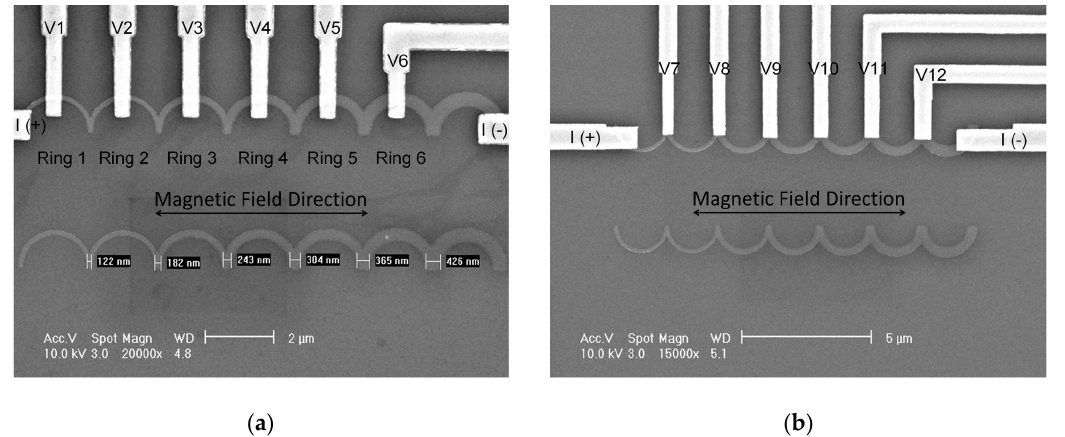
Figure 1. SEM micrograph of half-ring wires with I / V leads. ( a ) Middle-contact half-ring wire; ( b ) corner-contact half-ring wire.